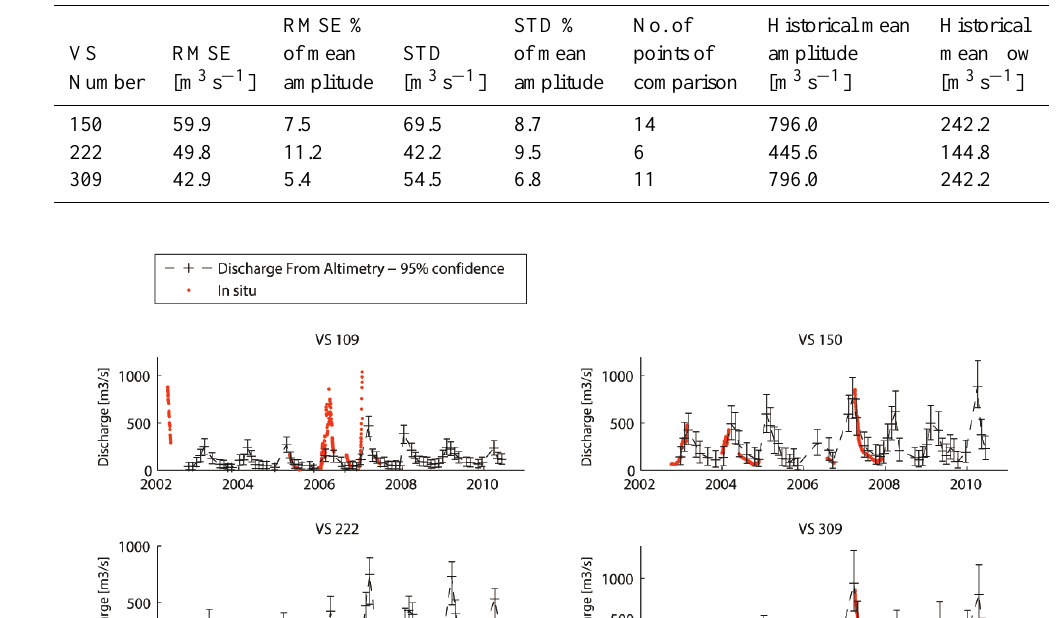
Table 3. Results for discharge calculations using method 2.